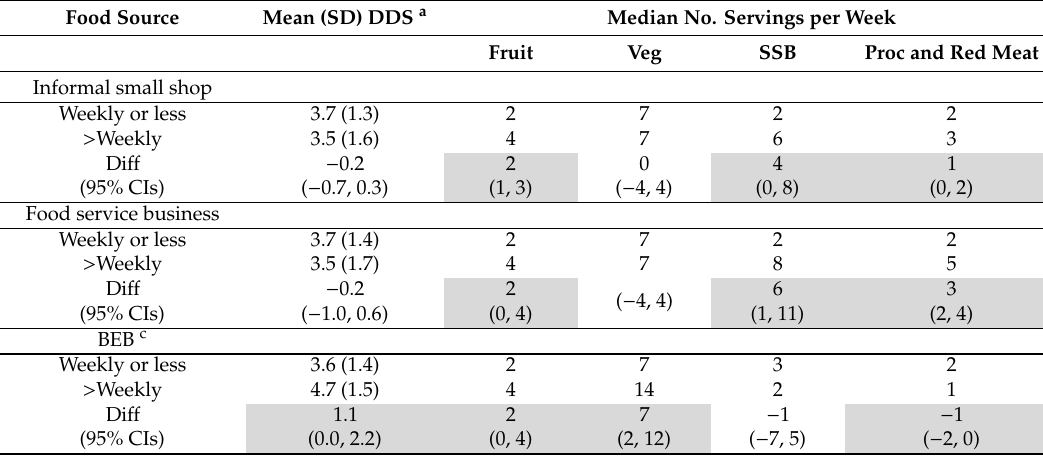
Table 7. Aspects of diet by frequency of use of selected food sources in the CFaH project in SVG. *.